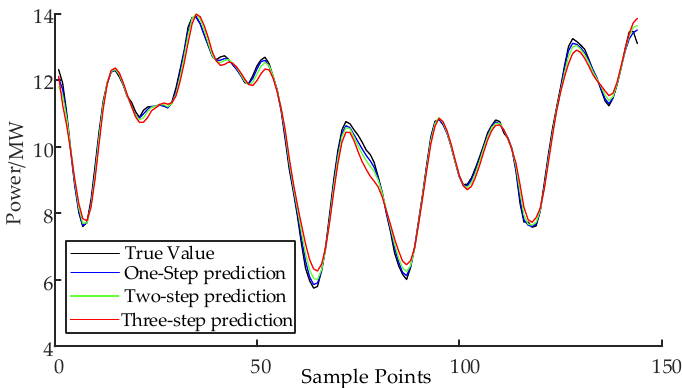
Figure 5. Uncorrected one-two-three-step prediction value.